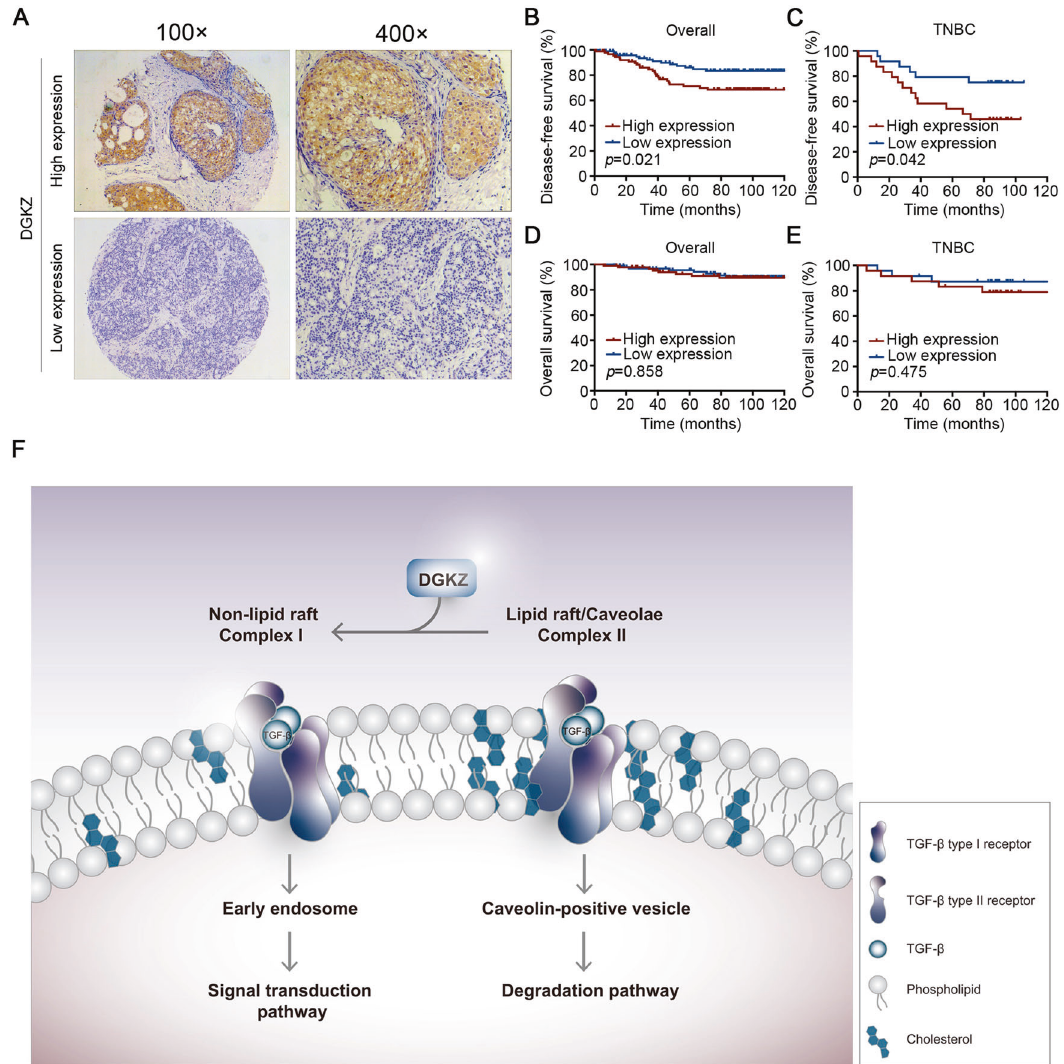
Fig. 5 High DGKZ expression correlates with poor prognosis. A Immunohistochemical analysis of the expression of DGKZ in TMAs. B , C The correlation of the expression of DGKZ with disease-free survival (DFS) in all patients and TNBC subtypes. D, E The correlation of the expression of DGKZ with overall survival (OS) in all patients and TNBC subtype. F A novel model for the regulation of the TGF β signaling pathway by